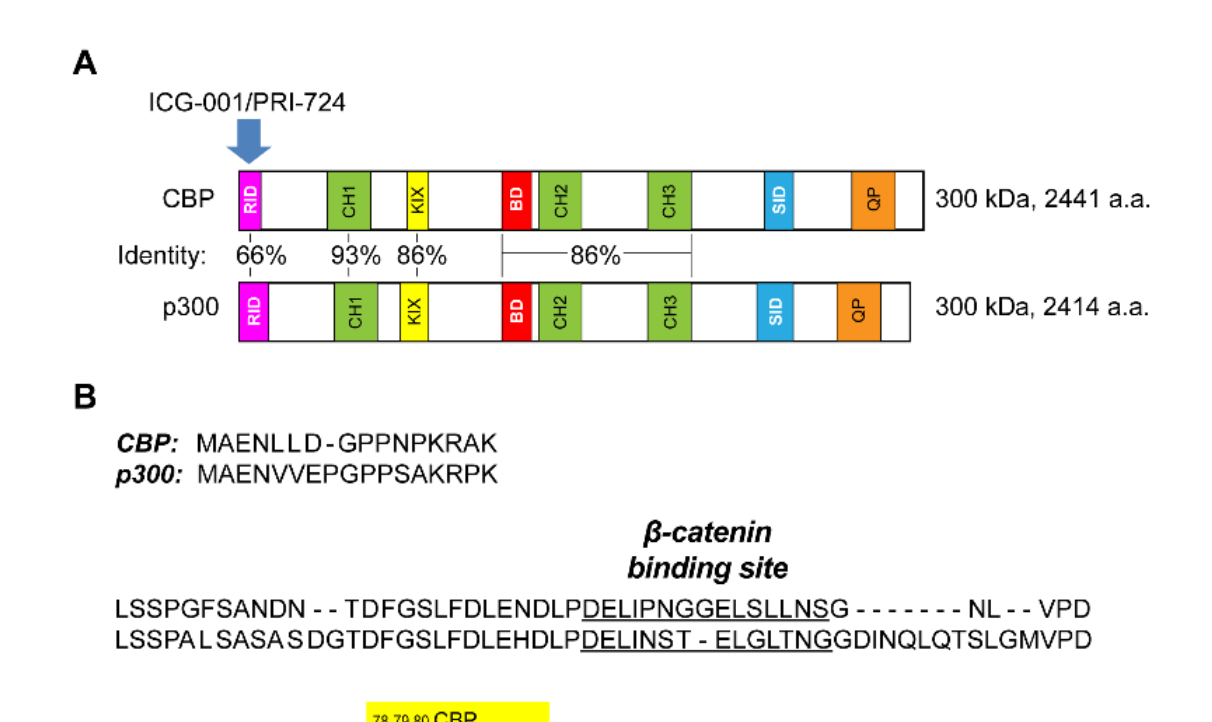
Figure 1. Differential usage of homologous Kat3 coactivators CBP and p300 by β -catenin. ( A ) Schematic representation displaying identity between CBP and p300. CBP and p300 have molecular weights of approximately 300 kDa and are encoded over 33 and 31 exons and consist of 2441 and 2414 amino acids (a.a.), respectively. β -catenin competes with direct small molecule CBP/catenin antagonists (PRI-724/ICG-001) for binding to CBP’s (but not p300 (cid:48) s) distal N-terminus, the least conserved region within these two Kat3 coactivators. CBP, cAMP response element binding protein (CREB)-binding protein; p300, E1A-binding protein, 300 kDa; RID, receptor-interacting domain; CH, cysteine/histidine region; KIX, kinase-inducible domain interacting domain; BD, bromodomain; SID, steroid receptor co-activator-1 interaction domain; QP, glutamine- and proline-rich domain. ( B ) Sequence alignment of the distal N-terminal regions of CBP and p300, showing conserved sites for binding of β -catenin (DELI motif). Note: p300 S89 is a critical residue controlling differential Kat3 coactivator usage by β -catenin. (Human CBP and p300 sequences are depicted.)